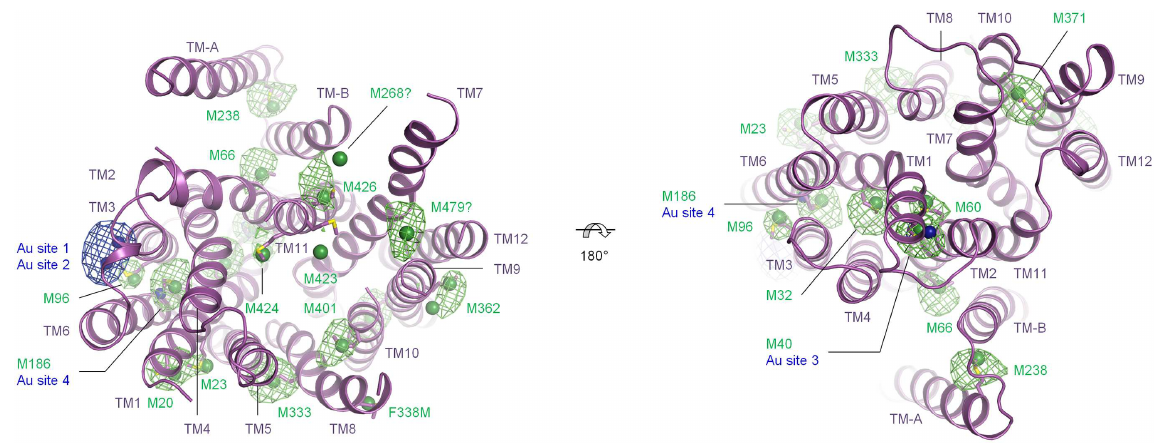
Fig 2. Site finding. The structure is magentaand the methionine side chains are shown in sticks and labeled,green and blue spheresdesignate AutoSHARPSeMet and Au sites, respectively,and the similarlycolored wire meshes designate the model phased SeMet and Au anomalous difference Fourier maps contouredat 3 σ . Two views are shown: cytoplasmic (left) and periplasmic